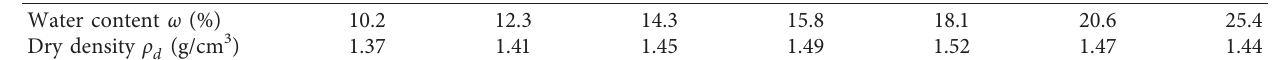
Table 3: Loess-lime compaction test results.